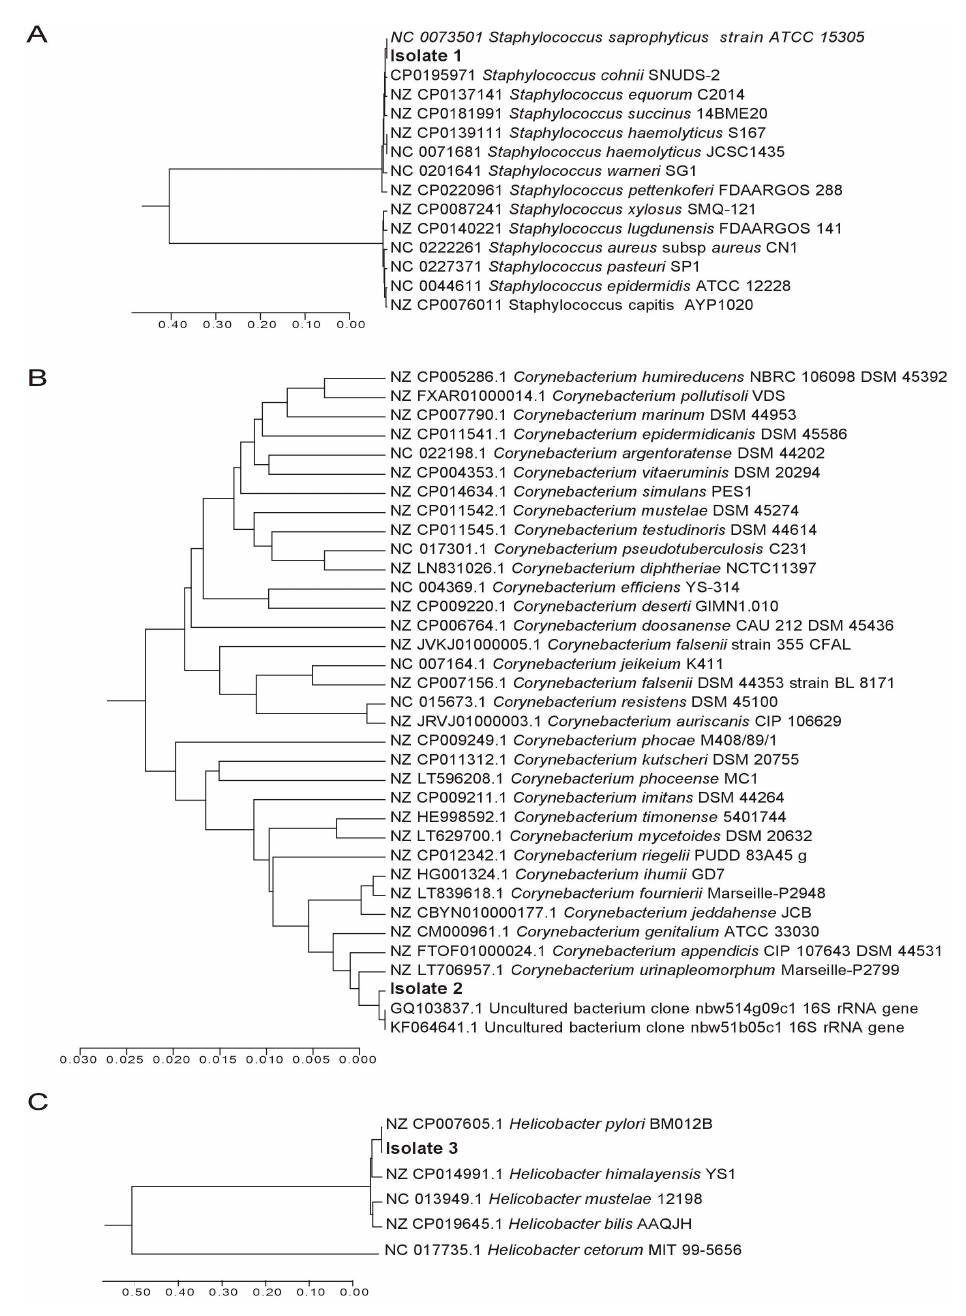
Figure 1. Three isolates of live bacterial species isolated from the gallbladder of a patient with cholecystitis were subjected to 16S rRNA gene sequencing and phylogenetic analysis. The DNA relatedness of sequences with known taxa is shown using the unweighted pair group method and arithmetic average method (UPGMA). The optimal tree with the sum of branch length was 1.04, 0.51, and 1.22 for panels ( A – C ), respectively. All positions containing gaps and missing data were eliminated, and the analyses were conducted in